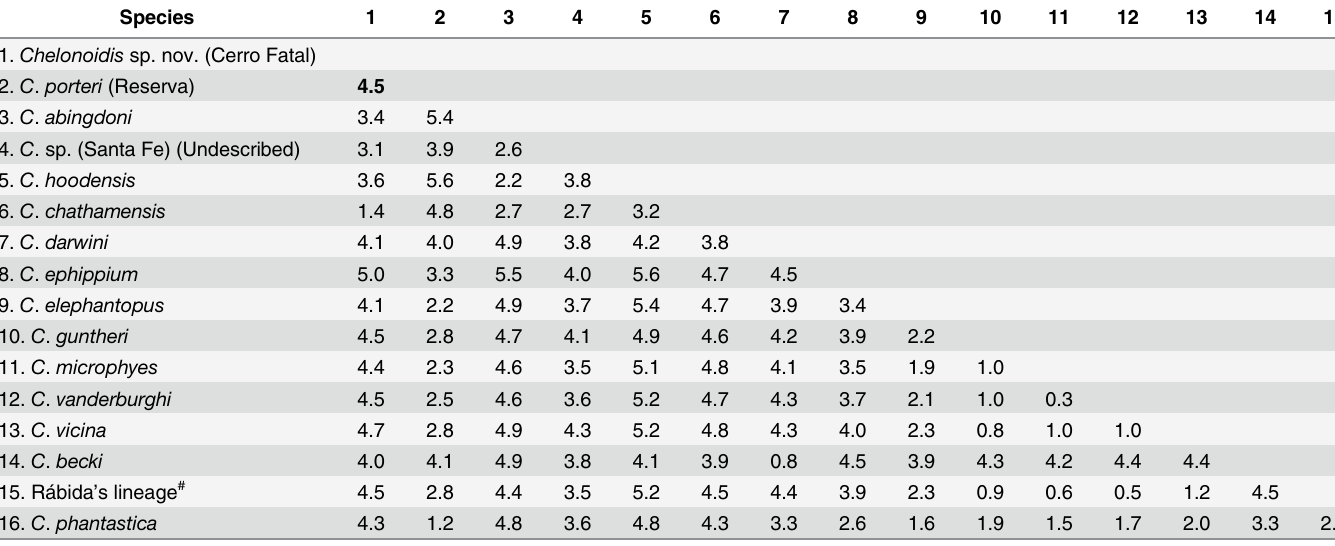
Table 3. Sequence divergences (%, uncorrected p-distance) among the mtDNA control region sequences of Chelonoidis sp. nov. (Cerro Fatal) and all the recognized species of giant Galapagos tortoises.